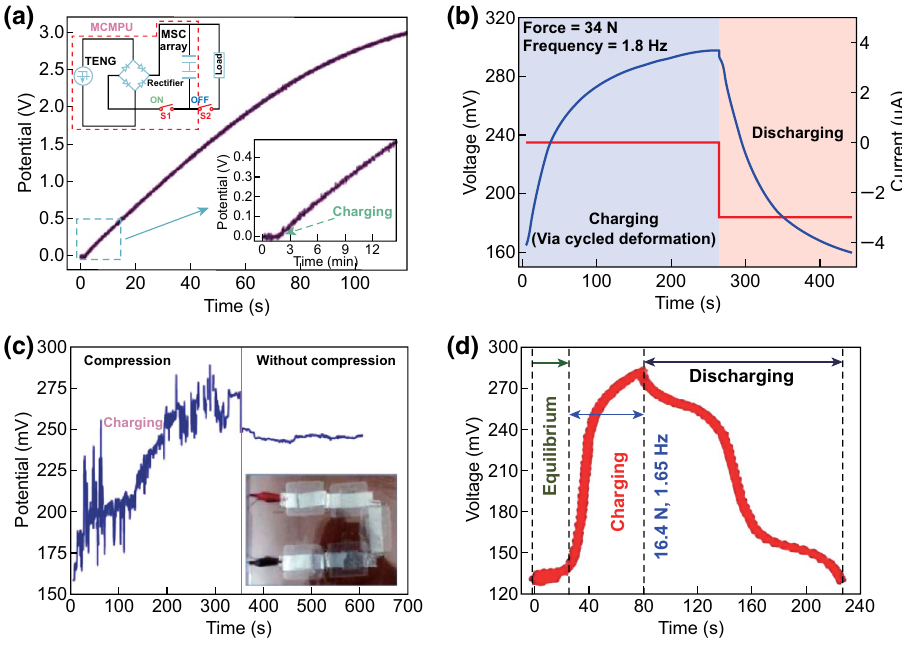
Fig. 10 a Charging curve of the MSC array component. Reprinted with permission from Ref. [15]. b A typical self‑charging process under peri‑ odic compressive stress of a SCPC fabricated using PVDF mesoporous nanostructured film as piezo‑separator. Reprinted with permission from Ref. [16]. c Self‑charging process of the serially connected five SCSPCs under periodic compressive strain provided by human palm impact to the whole devices. Reprinted with permission from Ref. [17]. d The self‑charging‑discharging profile under continuous human finger imparting. Reprinted with permission from Ref.